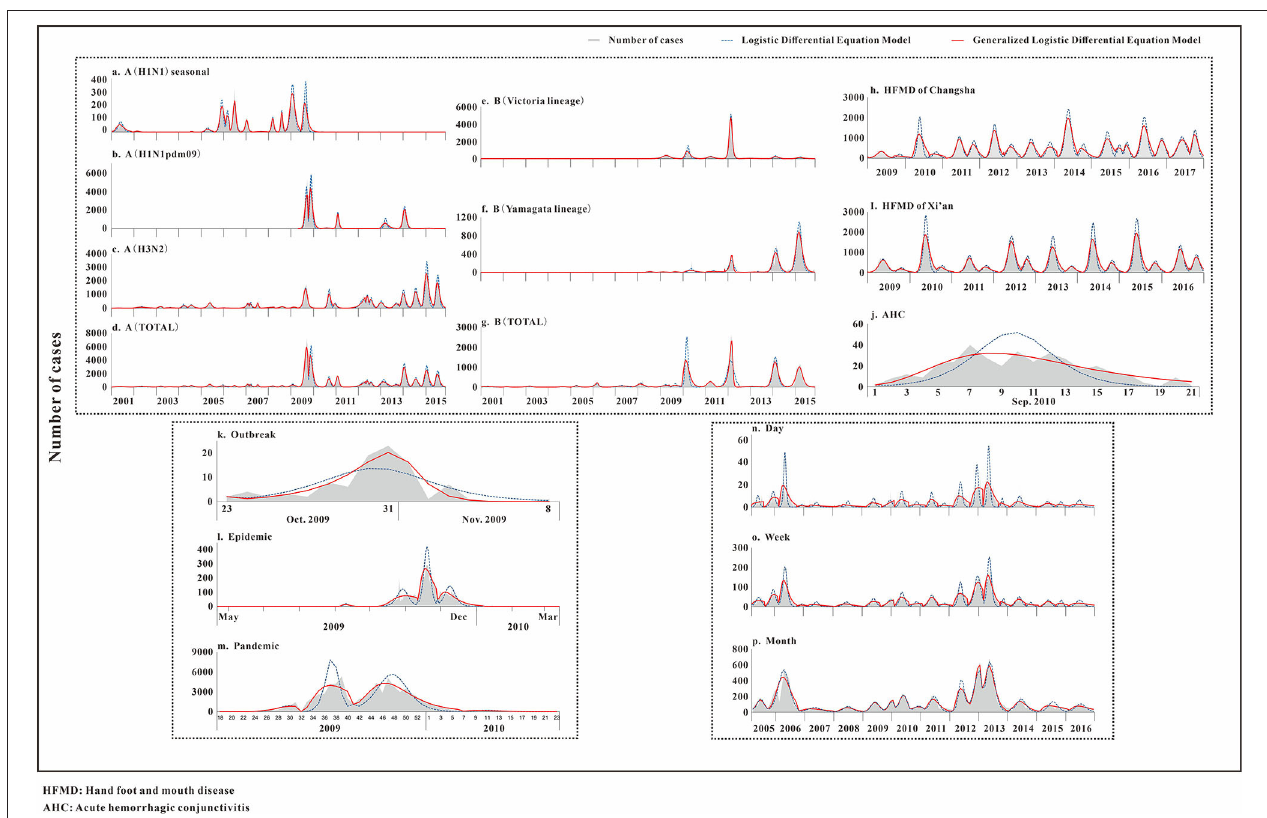
FIGURE 4 | Curve fitting results of logistic and generalized logistic differential equation models. (a) A (H1N1) seasonal, (b) A (H1N1pdm09), (c) A (H3N2), (d) A (Total), (e) B (Victoria lineage), (f) B (Yamagata lineage), (g) B (Total), (h) HFMD of Changsha, (i) HFMD of Xi’an, (j) AHC, (k) Outbreak, (l) Epidemic, (m) Pandemic, (n) Day, (o) Week, and (p) Month. HFMD, Hand foot and mouth disease; AHC, Acute hemorrhagic